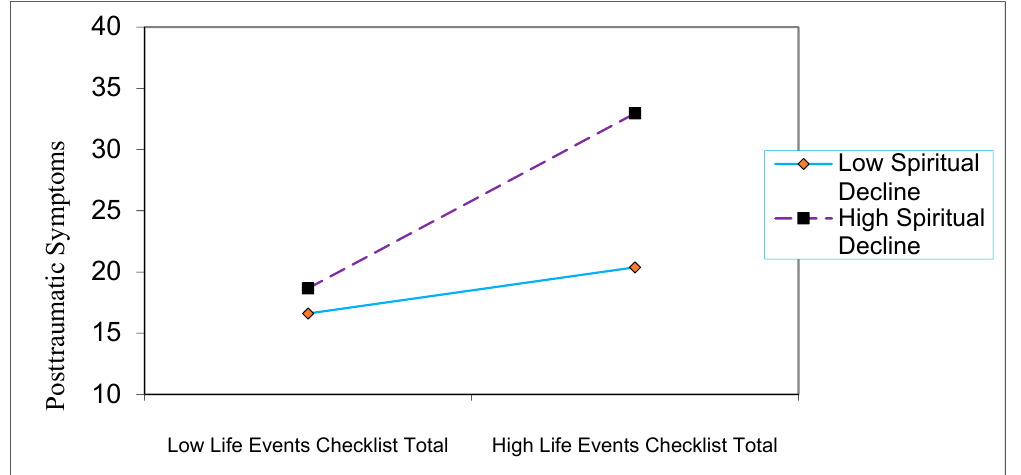
Figure 1. Interaction of Life Events and Spiritual Decline on Posttraumatic Stress Symptoms.